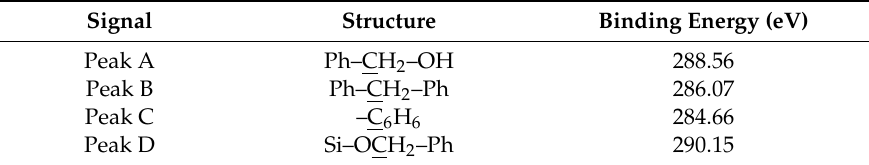
Table 2. Corresponding C1s data of Figure 5.